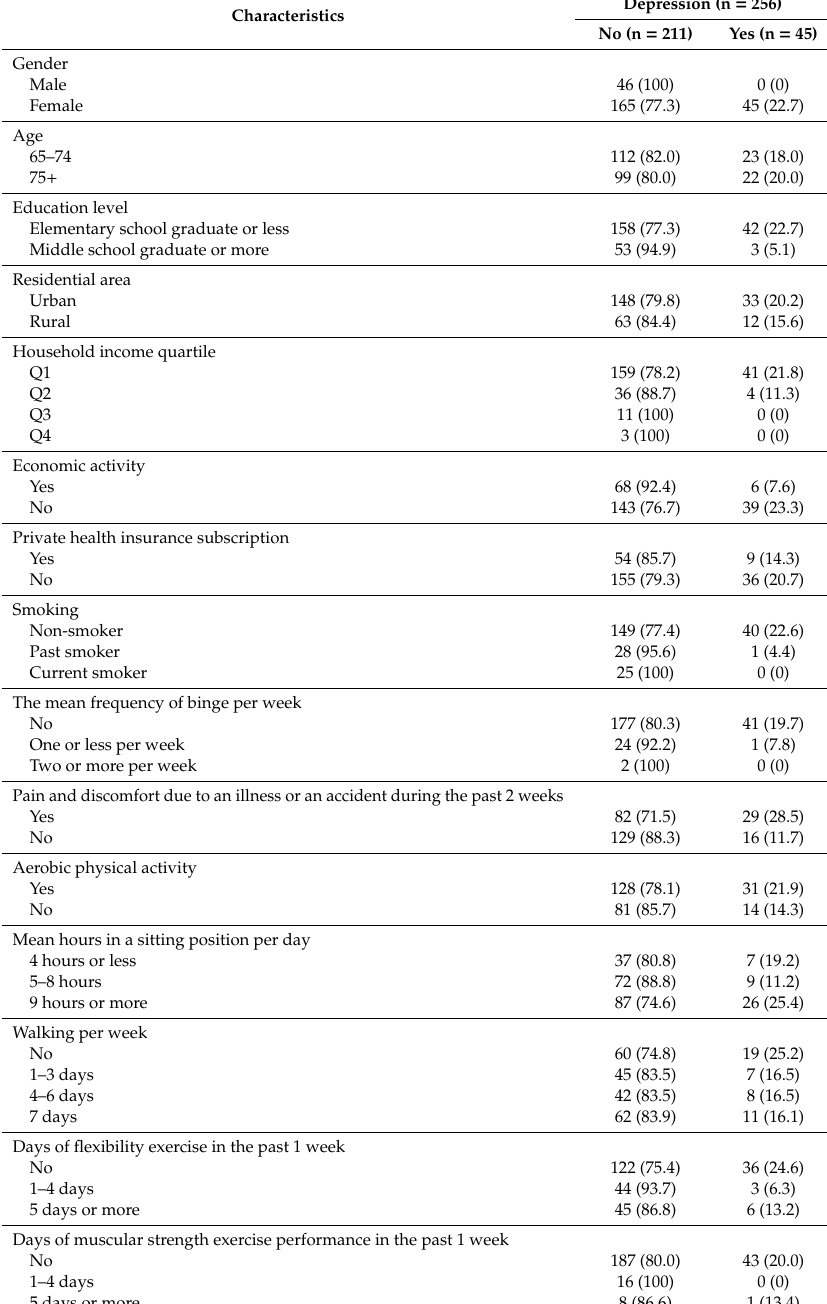
Table 2. Characteristics of subjects by the prevalence of depression, n (weight